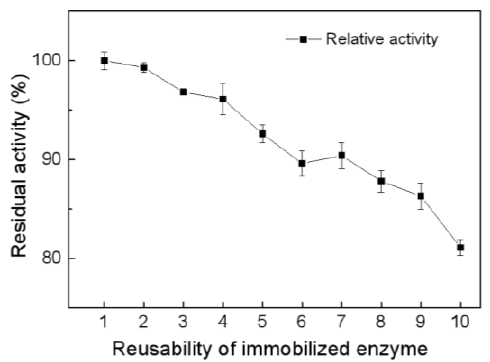
Figure 8. Reusability of immobilized Melac13220 for the oxidation of ABTS.